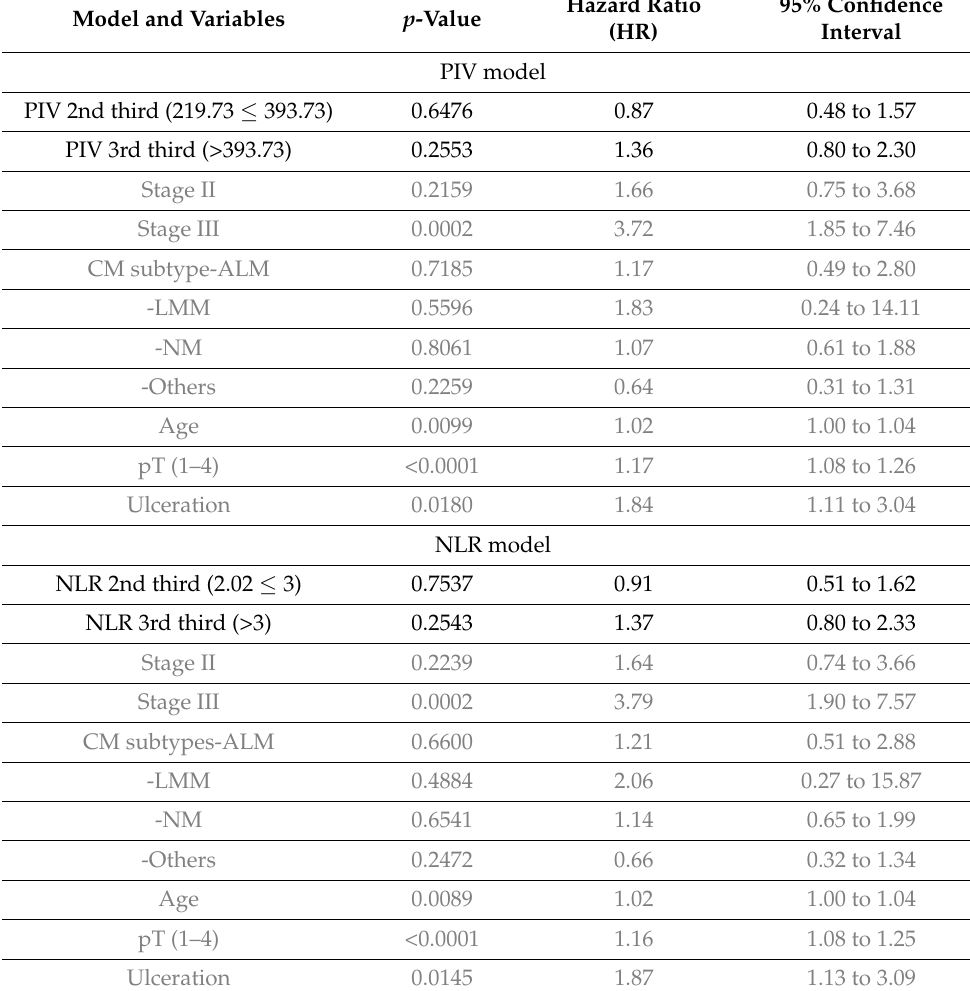
Table 3. Cox proportional hazards regression model for cutaneous melanoma (CM)-specific survival and the total effects for the pan-immune-inflammation value (PIV) and neutrophil-to-lymphocyte ratio (NLR) adjusted for potential